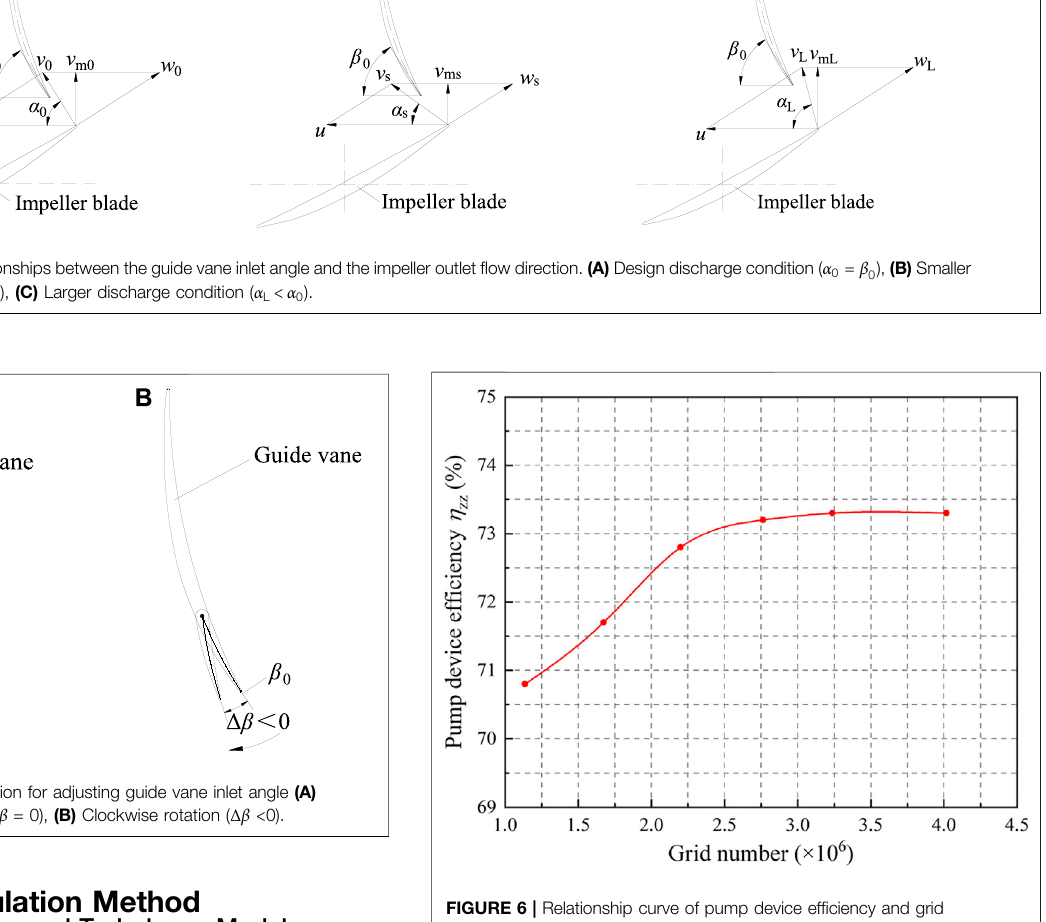
FIGURE 6 | Relationship curve of pump device ef fi ciency and grid